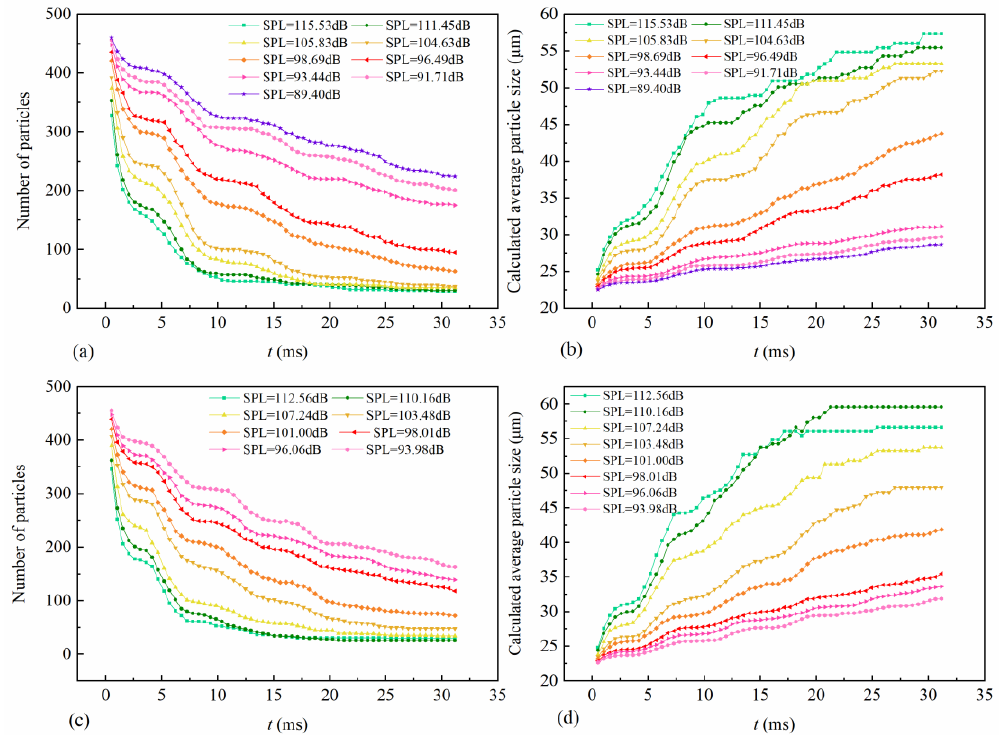
Figure 10. Impact of the SPLs on aerosol droplet particles ’ agglomeration: ( a ) plots of calculated average particle size under sound waves of f = 60 Hz; ( b ) plots of the number of particles under sound waves of f = 60 Hz; ( c ) plots of calculated average particle size under sound waves of f = 80 Hz; ( d ) plots of the number of particles under sound waves of f = 80 Hz.